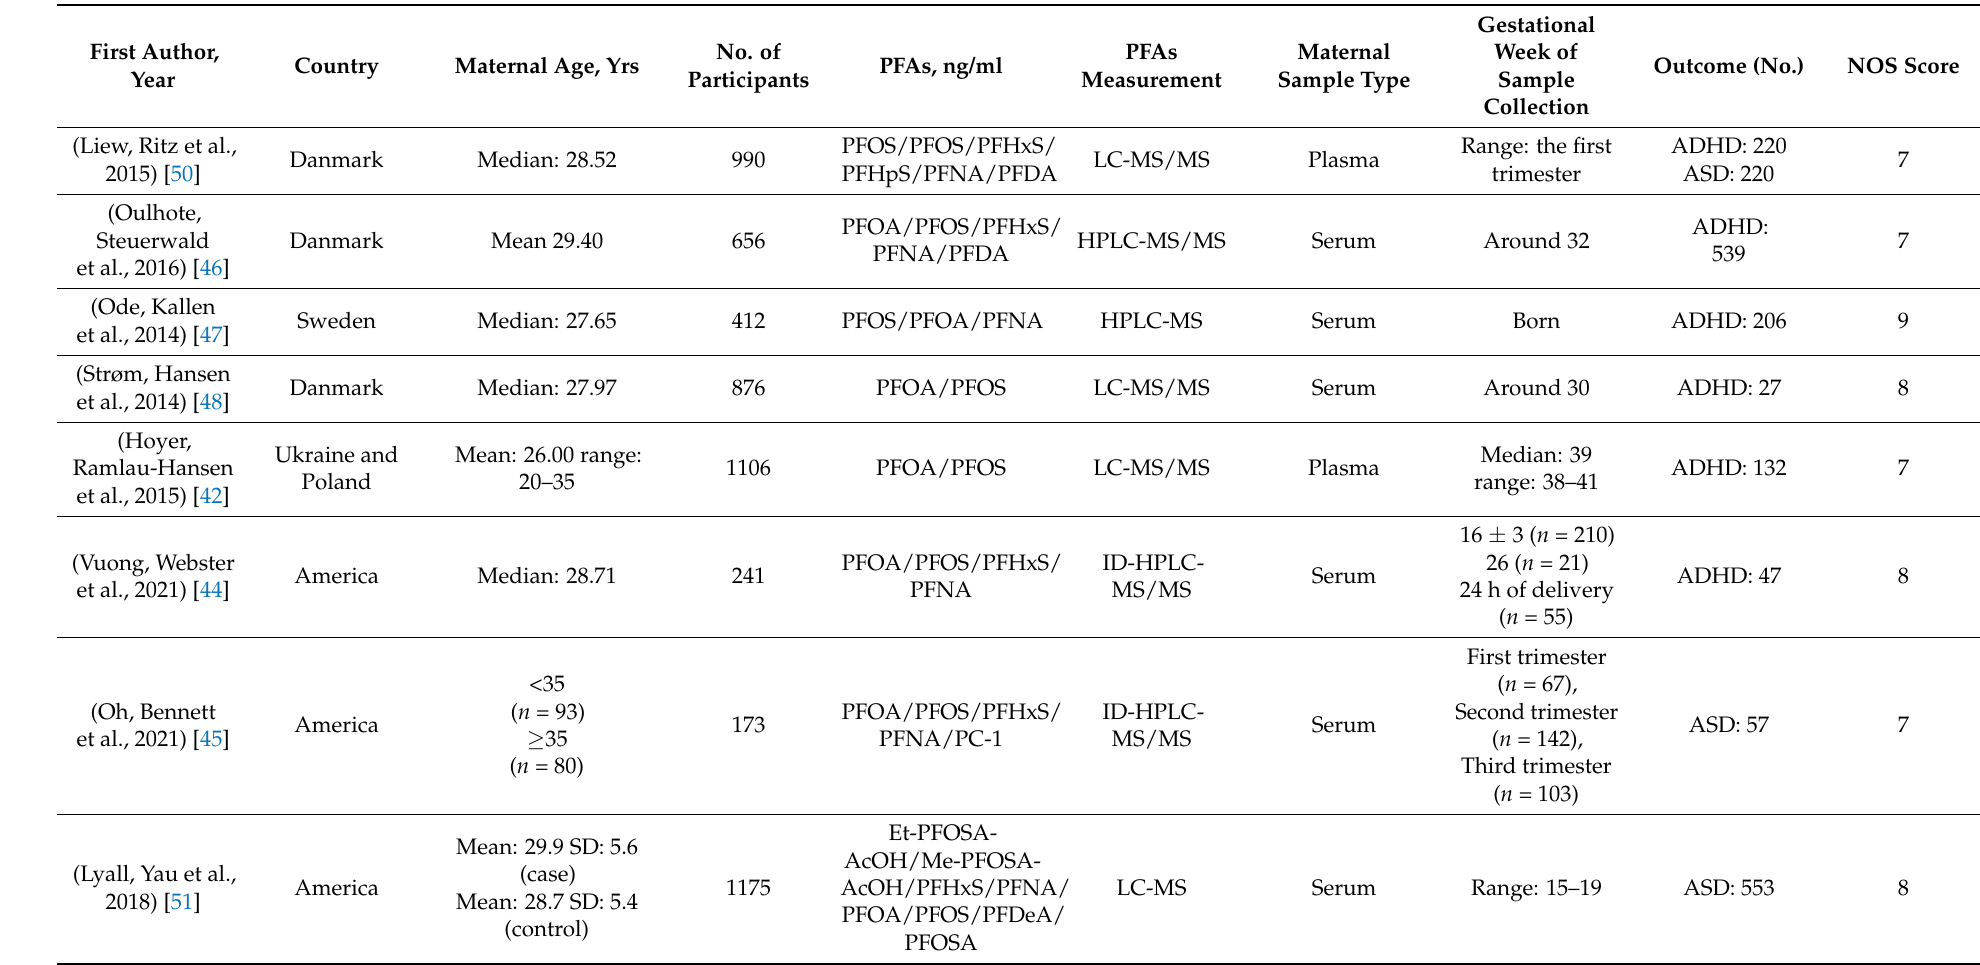
Table 1. The included studies on the association between prenatal PFAS exposure and neurobehavioral problems in